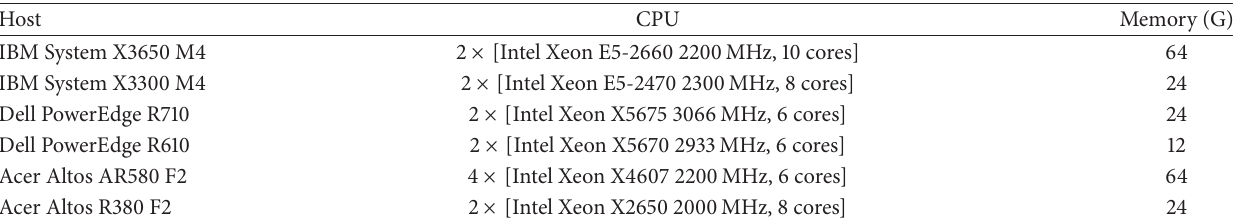
Table 2: Host models for CloudSim platform in the experiments.